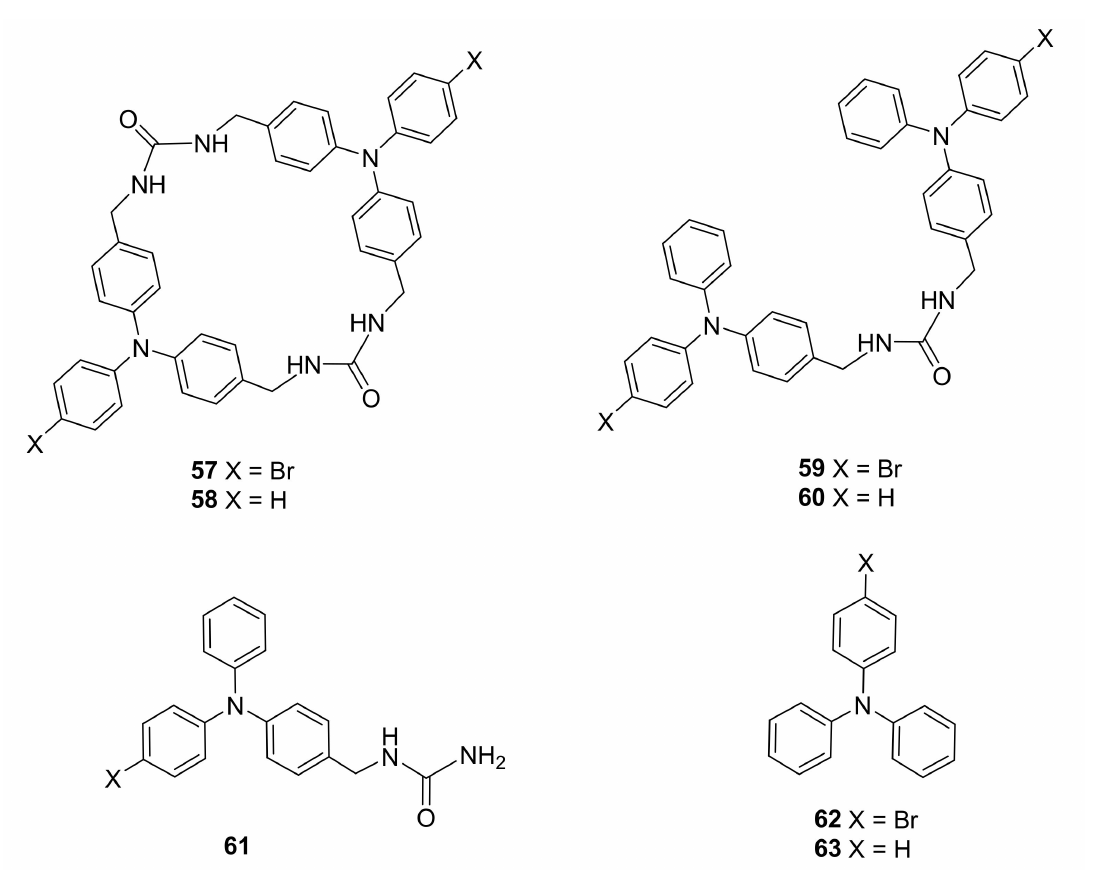
Figure 10. Electron-donor triphenylamine bis-urea macrocycles and their acyclic analogues containing common structural elements with selected guest